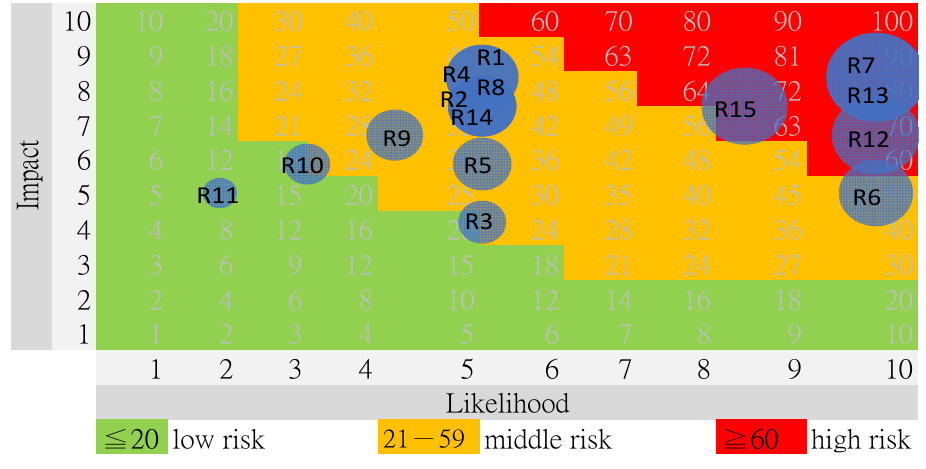
Figure 6. Risk matrix.